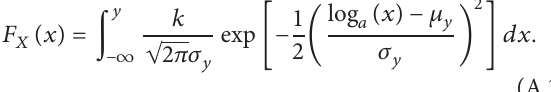
with the four PDMs (i.e., LN2, GAM2, GEV, and